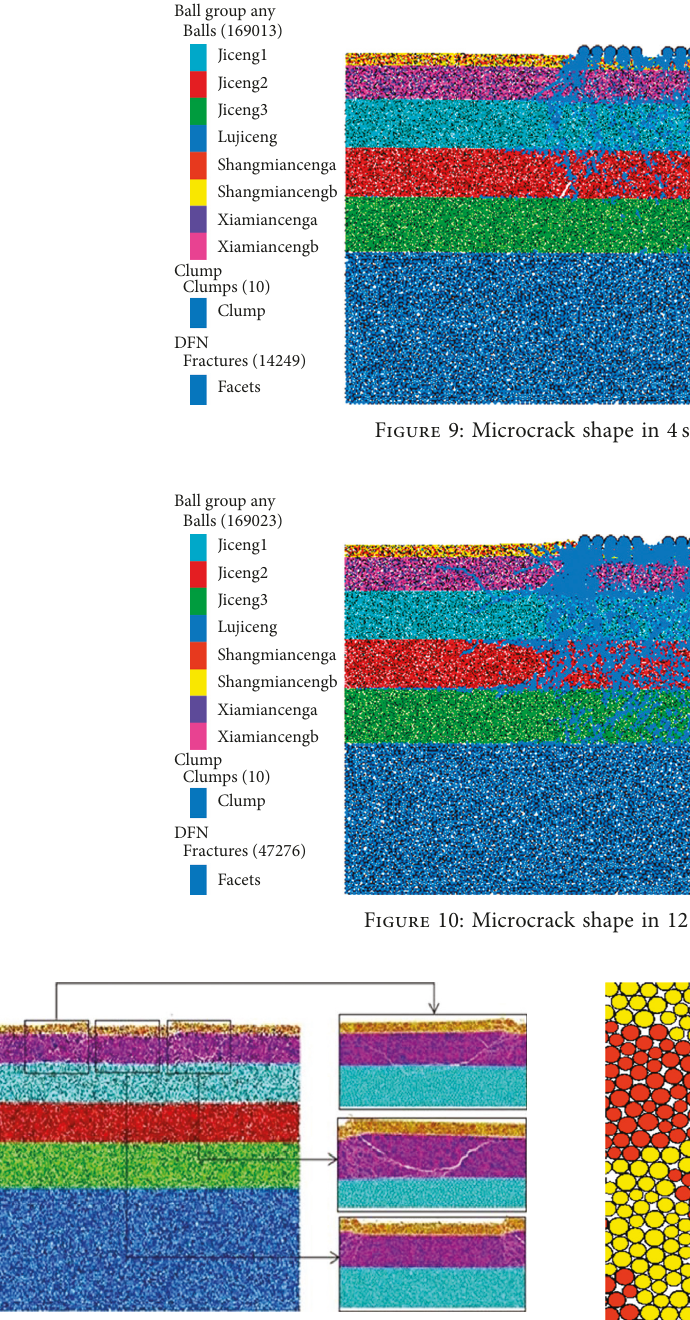
Figure 11: Macrocrack shape in 4seconds.